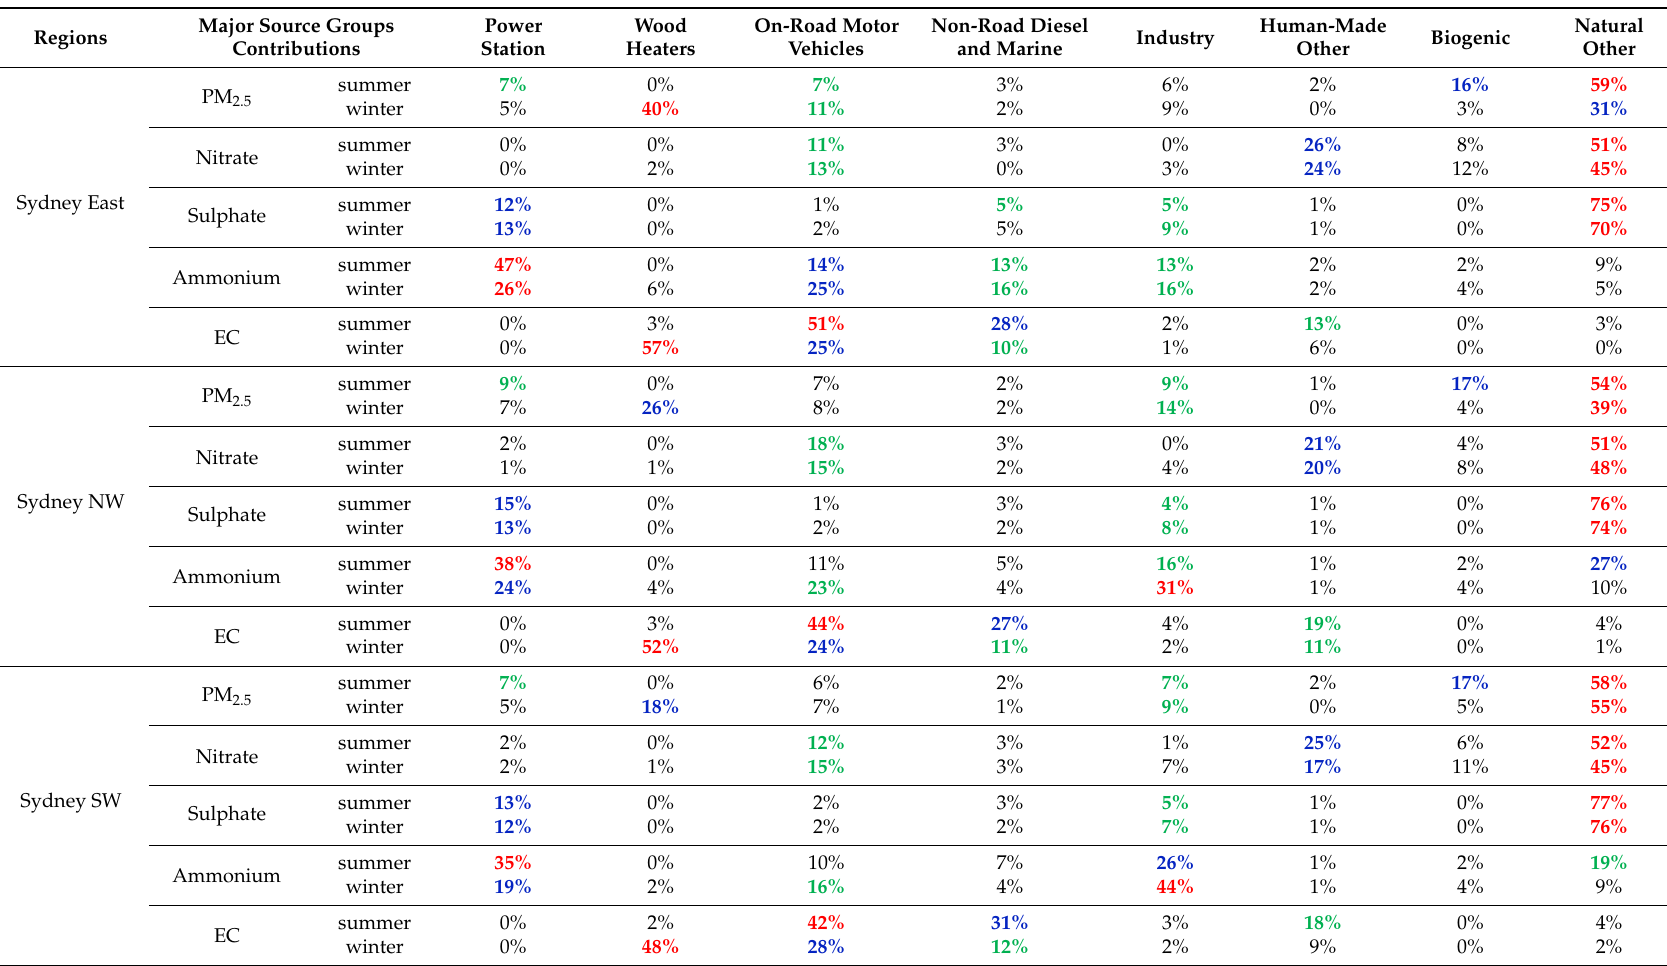
Table 3. The top three major source groups’ contributions (highlighted in red, blue and green, respectively) to total PM 2.5 mass, nitrate, sulphate, ammonium and elemental carbon at each of the five regions in NSW